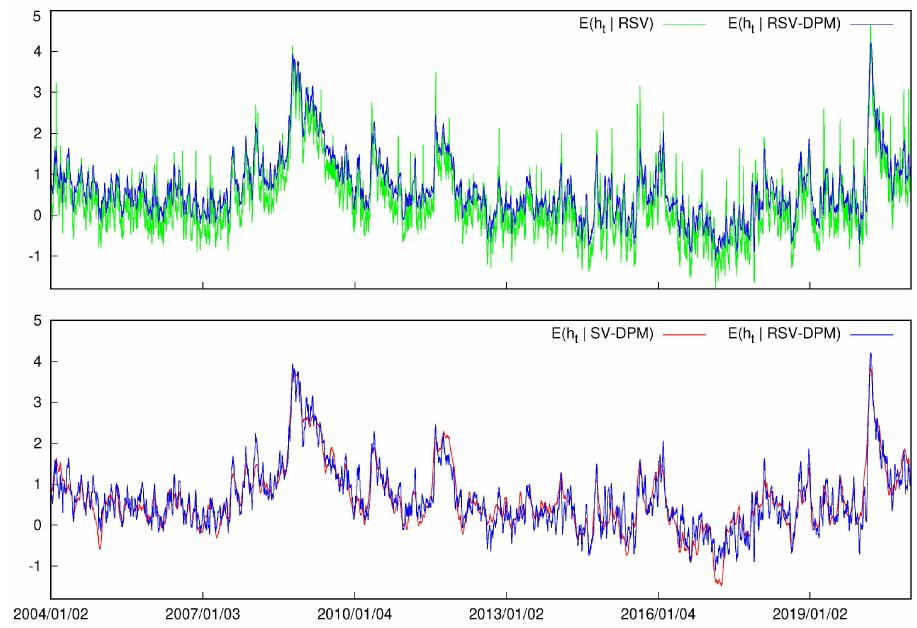
Figure 4. Posterior mean of log volatilities h t of DIS.